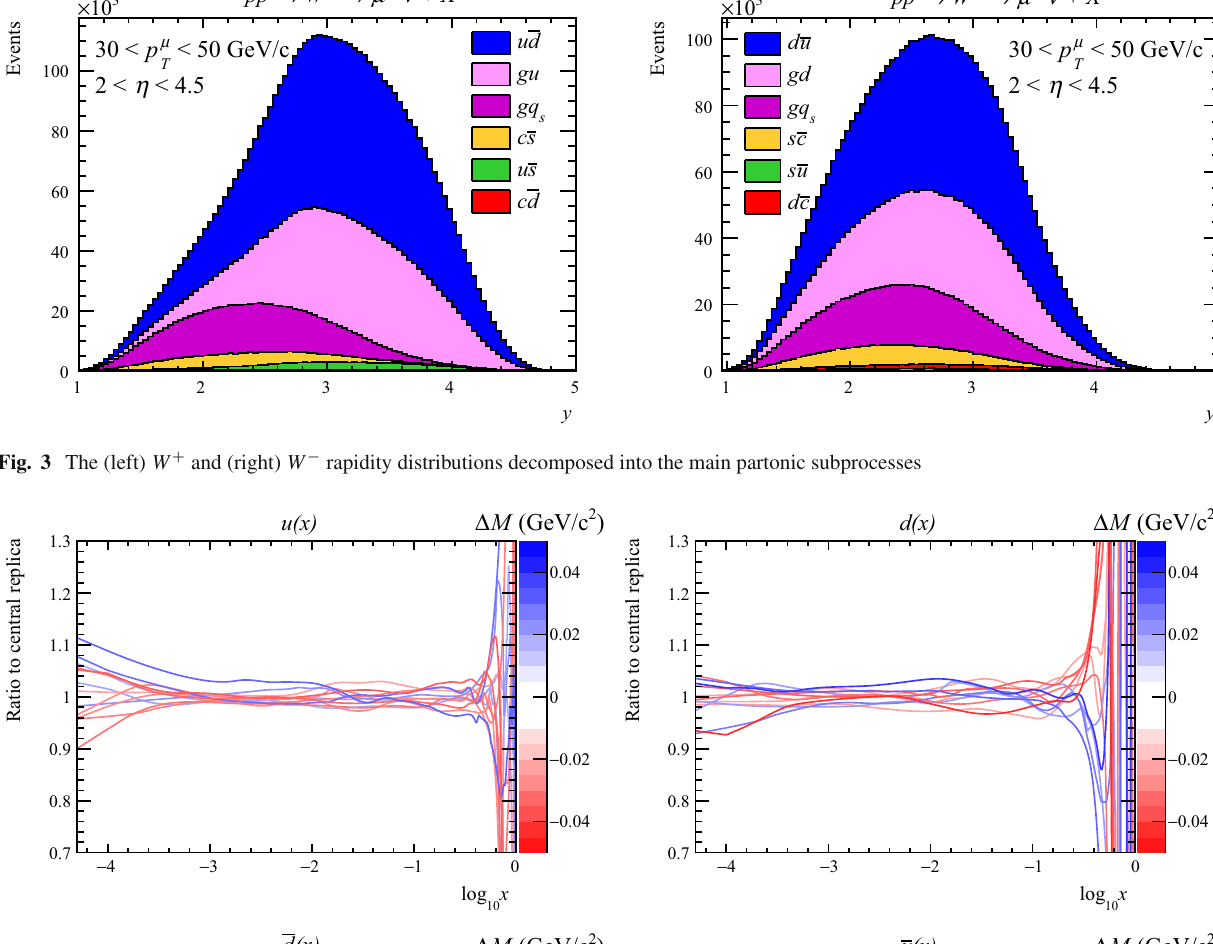
Fig. 4 The ratios of a subset of NNPDF3.1 replicas with respect to the central replica, for the x dependence of the (clockwise from upper left) u , d , ¯ u and ¯ d PDFs. Each line is marked with a colour indicating the